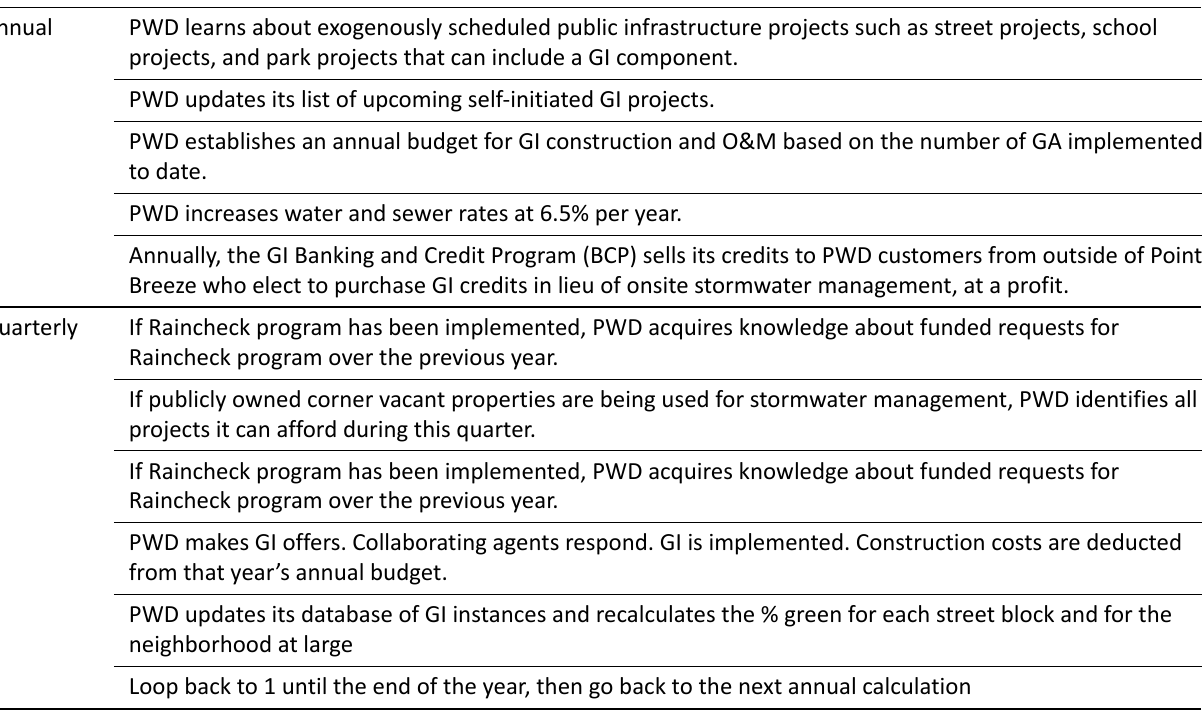
Table 2. Schedule of recurring events in the Point Breeze